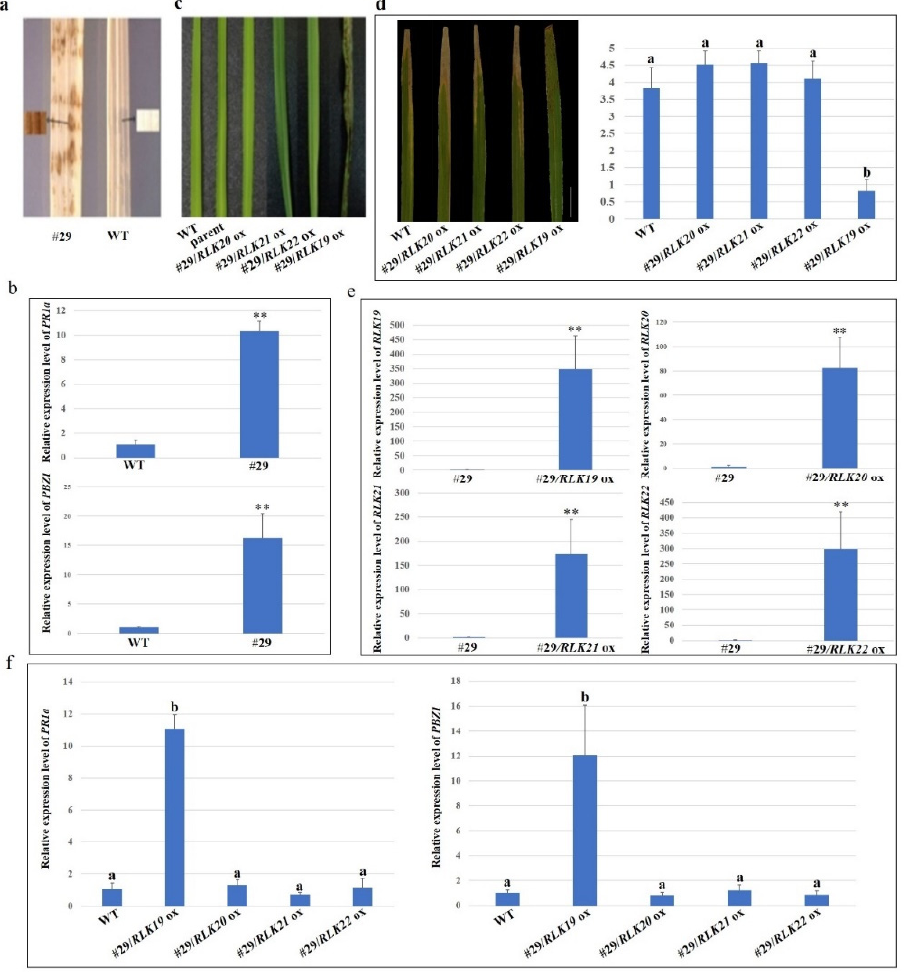
Figure 3. RLK20 , 21, and 22 can rescue the lesion mimic symptoms of the #29 mutant plant. ( a ) DAB staining of the #29 mutant and wild-type leaves. ( b ) The relative expression levels of PR1a and PBZ1 in WT (wild-type plants) and the #29 mutant plants. Data indicates the average ± standard error (SE) ( n > 6). **, p < 0.01 ( c ) The leaves of the WT (wild-type) plant, parent (plants with two Ds do not have alternative transposition on chromosome), #29/ RLK19 ox, #29/ RLK20 ox, #29/ RLK21 ox and #29/ RLK22 ox plants. #29/ RLK19 ox, #29/ RLK20 ox, #29/ RLK21 ox and #29/ RLK22 ox indicate over-expression of RLK19 , 20 , 21, and 22 in the #29 mutant. ( d ) Lesion length on leaves after inoculation with PXO86. Data indicates average ± standard error (SE) ( n =10). The letters a and b denote significant differences. p < 0.01. ( e ) The relative expression levels of RLK19 , 20 , 21, and 22 in #29/RLK19 ox, #29/RLK20 ox, #29/RLK21 ox, and #29/RLK22 ox plants, respectively. Data indicates average ± standard error (SE) ( n > 6). **, p < 0.01 ( f ) Relative expression levels of PR1a and PBZ1 in WT, #29/RLK19 , #29/RLK20 , #29/RLK21, and #29/RLK22 OX plants. Data indicates the average ± standard error (SE) ( n > 6). The letters a and b denote significant differences. p <